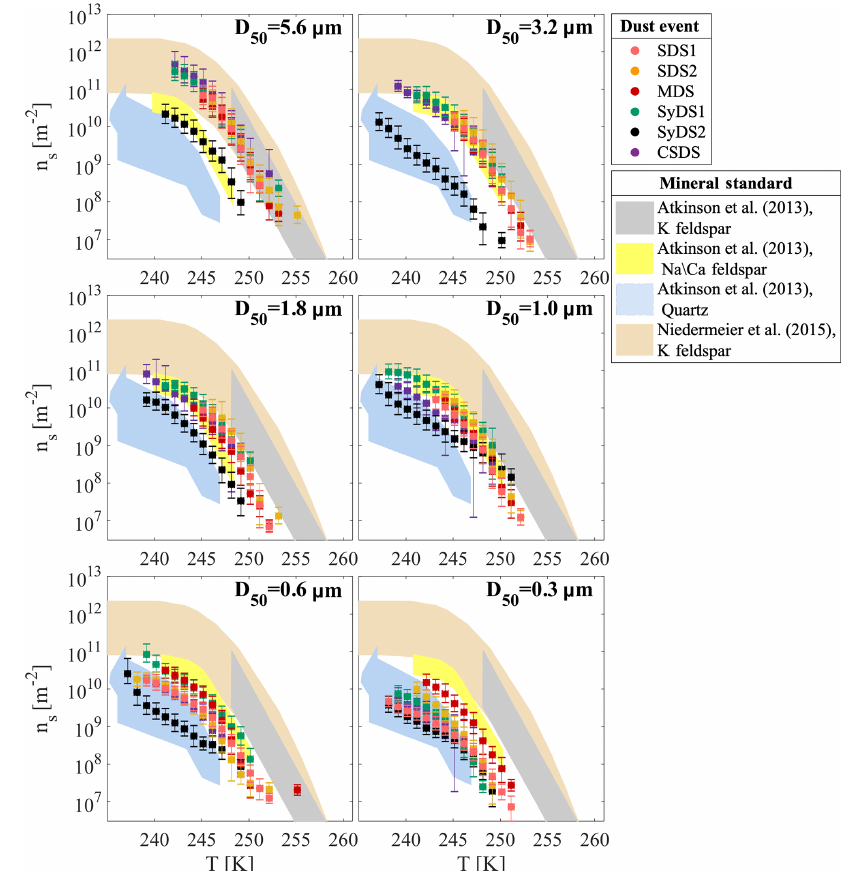
Figure 7. Ice-active site density during dust events in different particle size classes. Dust events from the Sahara (SDS), Syrian Desert (SyDS) or both (MDS) are marked by the different colors. Data for D 50 = 3 . 2, 1.8 and 1.0µm of SDS no. 2 adopted from Reicher et al. (2018). Relevant standard minerals scaled to ambient values are shown: K feldspar, Na–Ca feldspar and quartz from Atkinson et al. (2013), as well as K feldspar from Niedermeier et al.